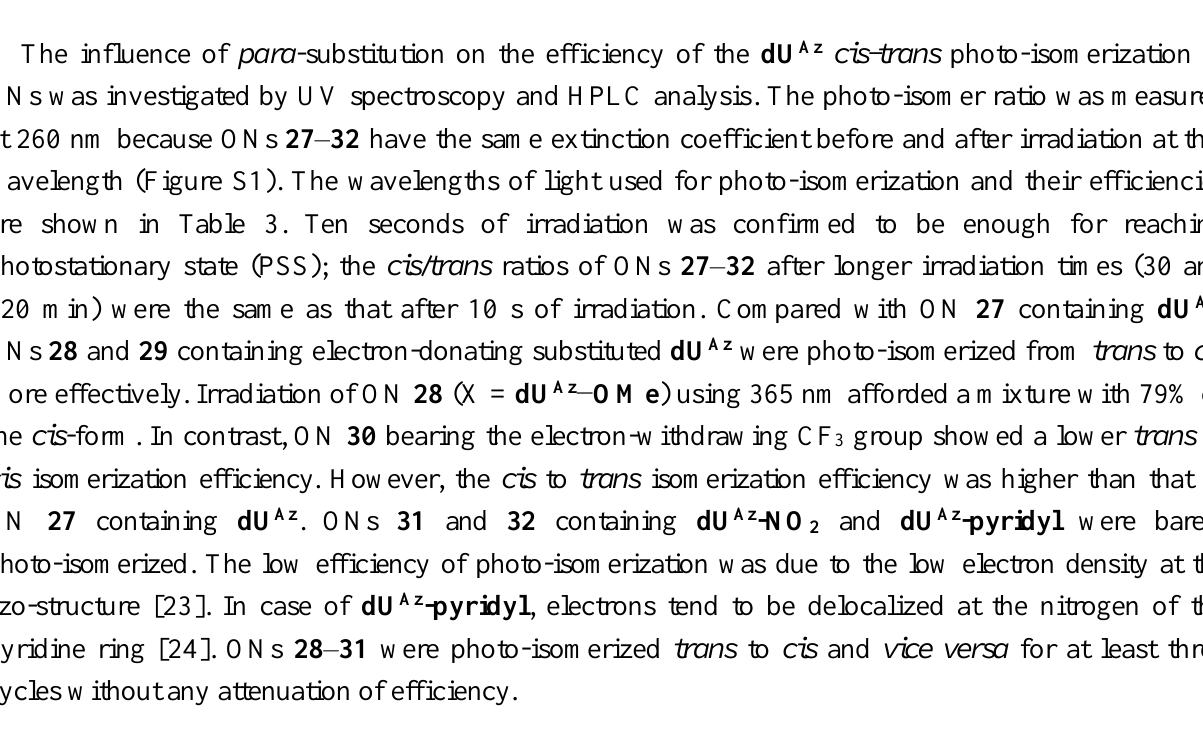
Table 3. Photo-isomerization properties of para -substituted dU Az a